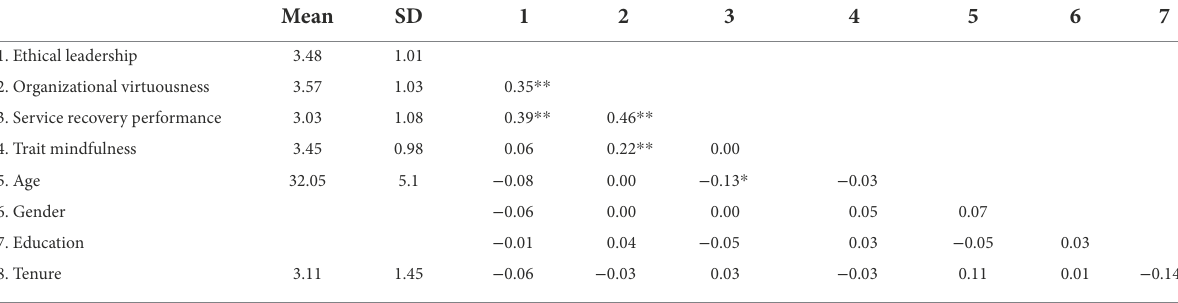
TABLE 1 Means and correlations.